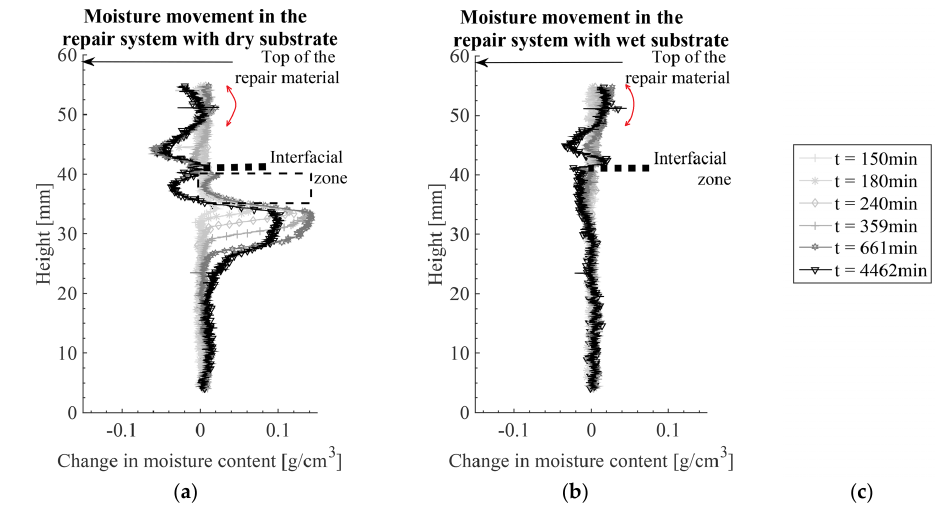
Figure 9. Moisture profiles in the repair systems as a function of time, t ( t after mixing the repair material): ( a ) dry substrate, w/c = 0.3, DS, S3; ( b ) wet substrate, w/c = 0.3, WS, S3 with the legend; and ( c ) legend.